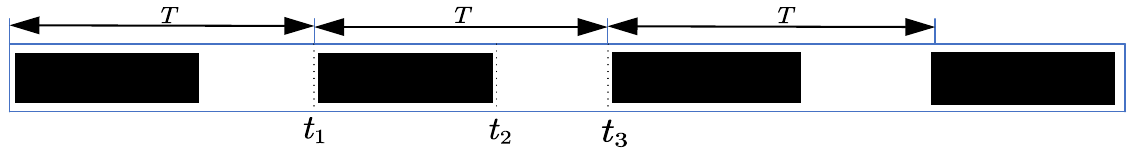
Figure 8. A gait phase diagram of one of the limbs of a quadruped animal.